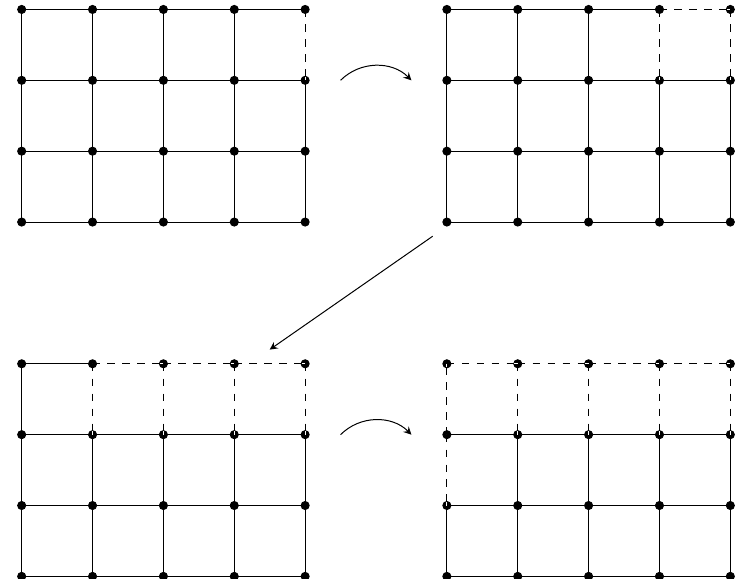
(cid:3) P . Proceed until n m